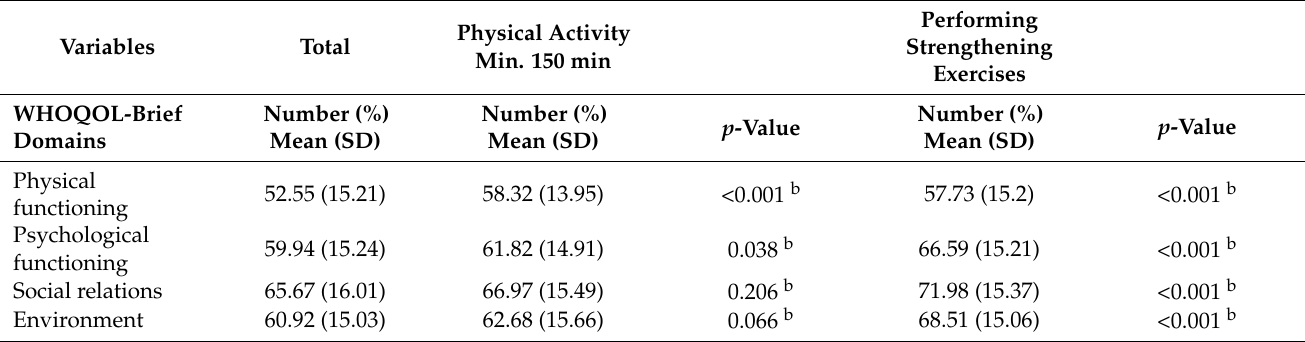
Table 3. Characteristics of quality of life of people aged 75–90 years ( n = 858).